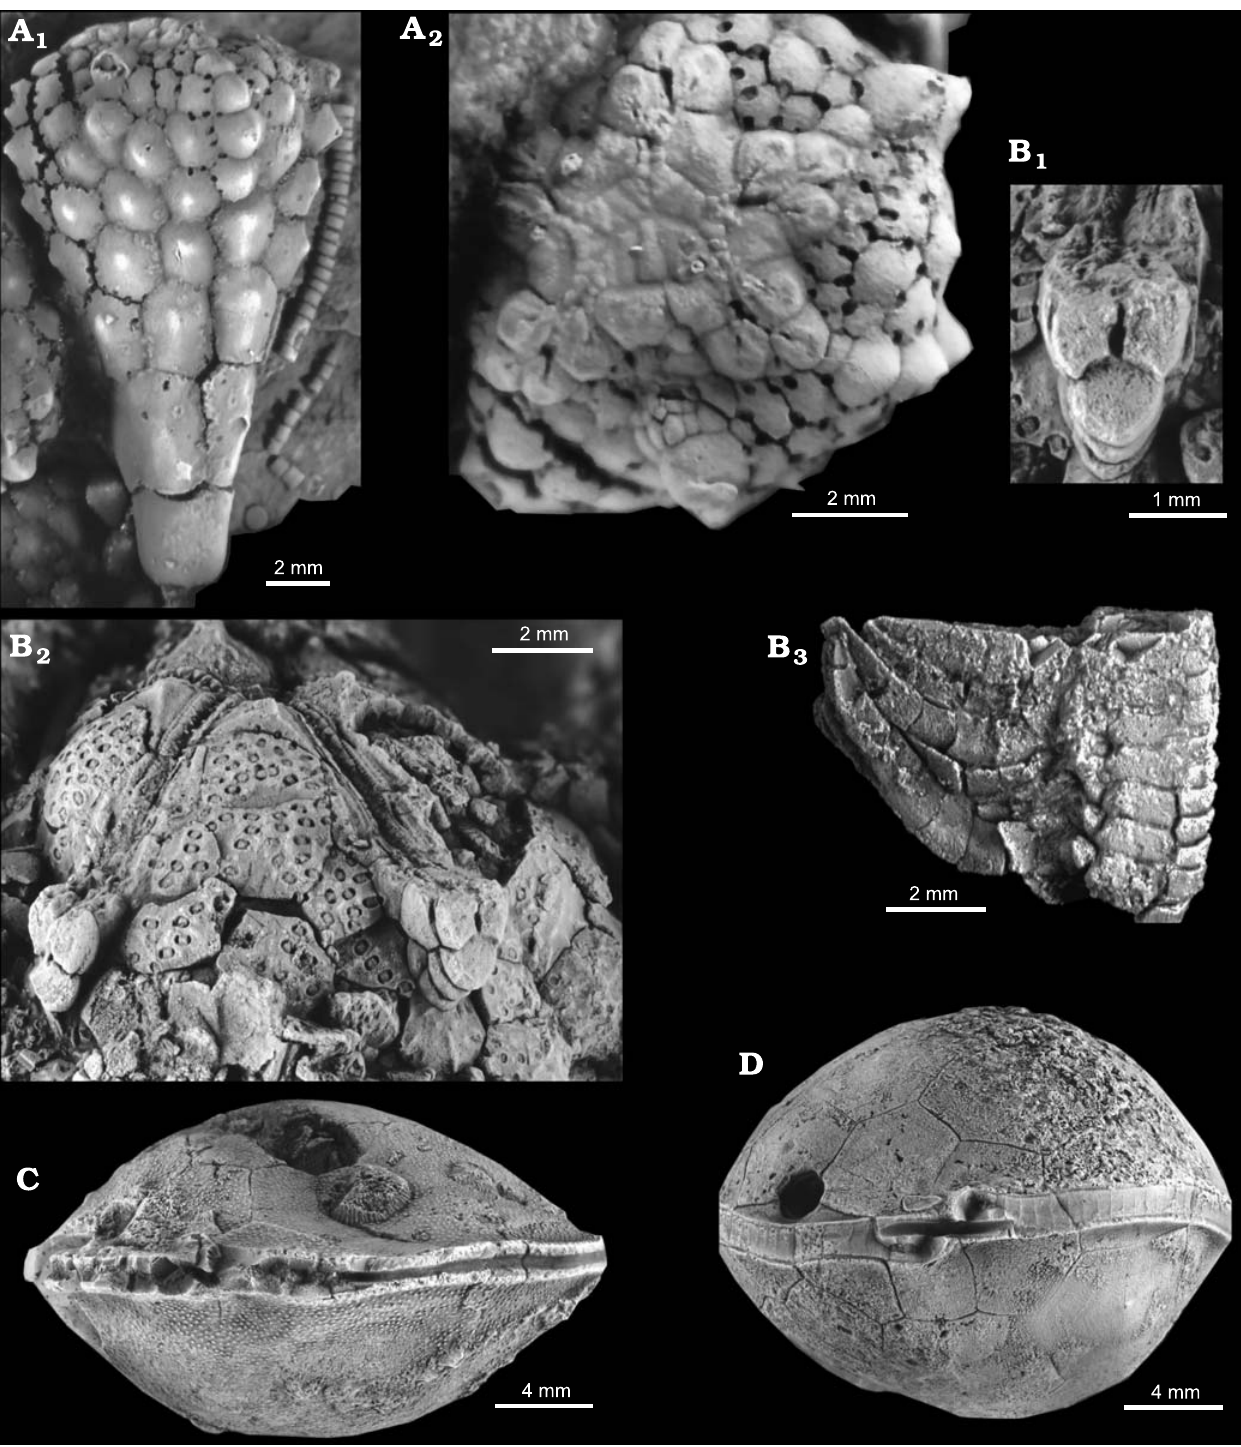
Fig. 8. Examples of derived blastozoans with superficial crinoid-like expressions. A . Eocrinoid Rhopalocystis destombesi Ubaghs, 1963 (PE 52747), Early Ordovician of Morocco; lateral view (A 1 ), showing derived superficially camerate-like thecal plating, lacking continuity between “fixed brachial”-like plates and feeding appendages, “rays” tapering, not aligned with ambulacra tips above; oral surface (A 2 ), showing typical biserial blastozoan brachiole facets. B . Diploporite-like blastozoan Eumorphocystis multiporata Branson and Peck, 1940 (TMM 1107TX2), Late Ordovician of Oklahoma, USA; with arm-like appendages superficially similar to crinoids. A ray feeding appendage stub near theca (B 1 ), showing triserial facets, cross-sectional plate shapes and sub-cen- tral ovate canal; thecal summit in A-B interray view (B 2 ), showing abrupt boundary between theca and feeding appendages, feeding appendages with thick- plated triserial pattern, diplopore-bearing thecal plates; feeding appendage segment with pinnule-like structures (B 3 ). C , D . Paracrinoid, Platycystites sp., Late Ordovician of Oklahoma, USA; oral surfaces of lenticular thecae, sub-ambulacral lumens revealed by natural spalling of brachiole-bearing ambulacrals, in continuity with the peristome. C . NPL 1113TX17, lumens short. D . NPL 1106TX13, lumens long. All Tremadoc crinoids are non-pinnulate